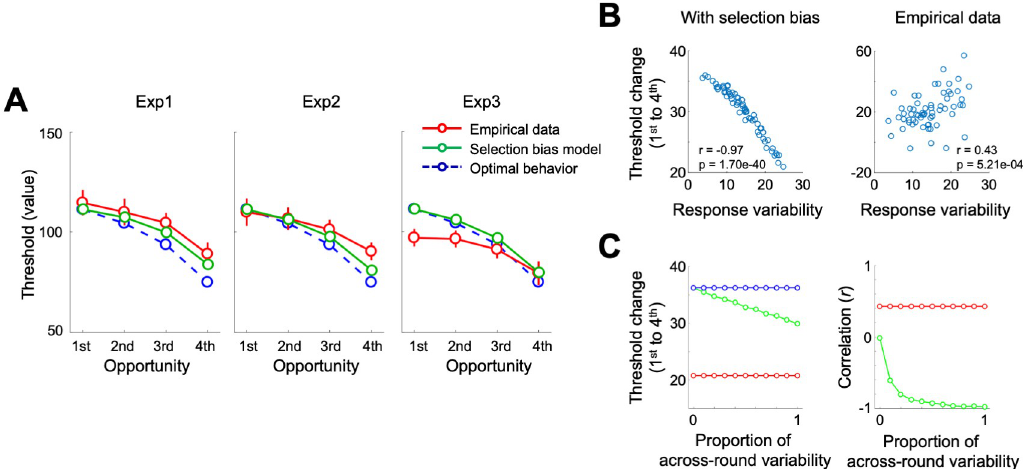
Fig 7. Subjective optimality model versus a potential impact of selection bias. Diminishing decision thresholds across opportunities alternatively may be driven by a combination of within-subject decision variability and selection bias where rounds in which decision thresholds happened to be higher (due to the within-subject variability across rounds) lasting further at later opportunities. (A) To directly examine this effect, decision thresholds simulated with a selection bias are compared against the optimal decision model and empirical data. The Selection bias model can explain the observed empirical data fairly well for some of the parts in Experiments 1 and 2, but not all of the patterns. Error bars indicate s.e.m. (B) We additionally examined the impact of different levels of within-subject variability on decision thresholds. There was a stark difference between the simulated and empirical data when probed through the association between within-subject variability and decision thresholds. The largest response variability in the Selection bias model was associated with the smallest threshold change across opportunities, and vice versa (r = -0.97, P = 1.70e-40). On the contrary, participants who had the largest response variability showed the largest threshold change across opportunities (r = 0.43, P = 5.21e-04), which is the exact opposite of the Selection bias model. Each dot represents individual simulation. (C) To examine the impact of across-round versus opportunity variability, we ran additional simulations with varying proportion of across-round variability out of the maximum amount of variability. As the proportion of variability attributed to across-round against the across-opportunity variability, the threshold-change gradually decreased from the level of the optimal behavior, and the correlation between threshold-change and response variability asymptotes to -1, decreasing from 0. Levels of threshold change for the empirical data (red) and the Optimal model (blue) are illustrated together as references.